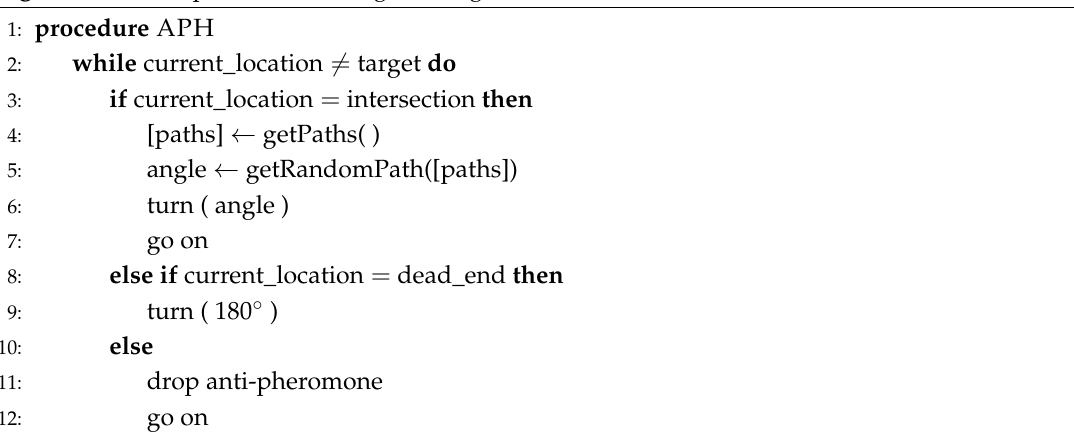
Algorithm 1 Anti-pheromone navigation